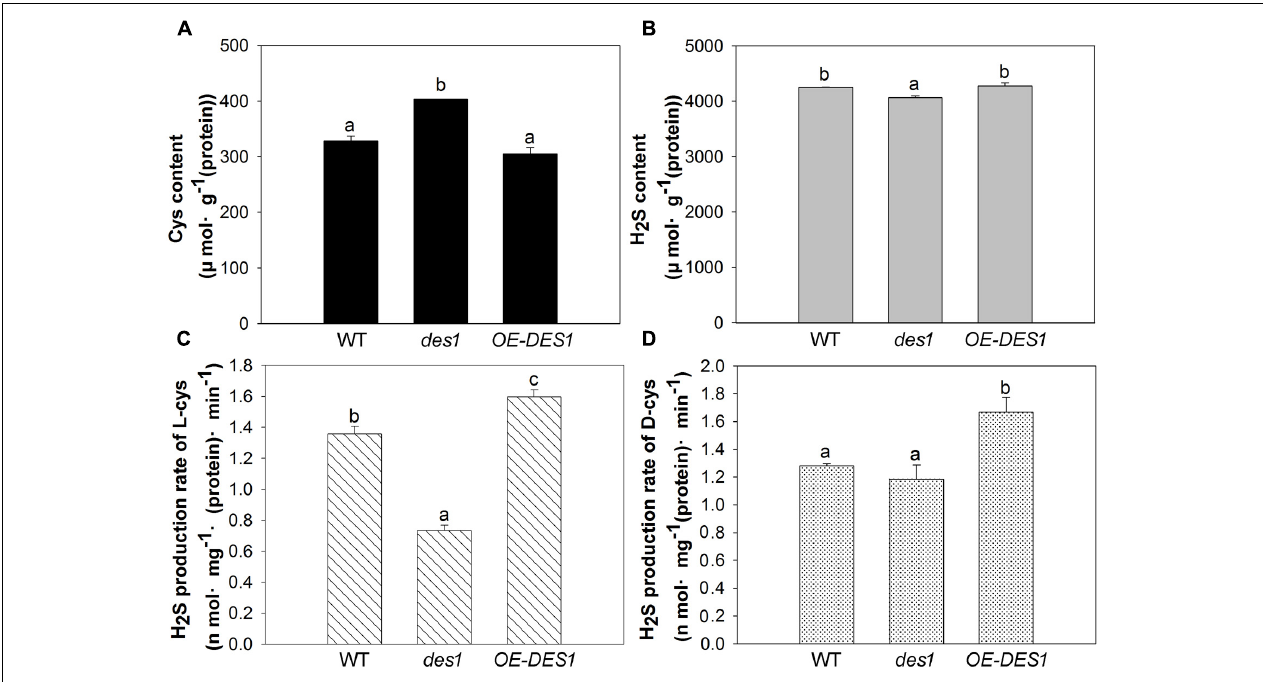
FIGURE 5 | Effects of drought stress on the H 2 S-related physiological indices in the mitochondria of WT, des1 and OE-DES1 . Leaves of 4-week-old after withholding water for 1 week were collected and the mitochondria were isolated and purified. (A) Cys contents of mitochondria were quantitated by the method described previously (Fu et al., 2012). (B) H 2 S contents of mitochondria were measured with electrodes (TBR4100 WPI, Sarasota, FL, United States). (C) H 2 S production rates of L -Cys and (D) H 2 S production rates of D -Cys in mitochondria of WT, des1 and OE-DES1 were measured with methylene blue method (Fu et al., 2012). Data are means ± SEs of three independent experiments; bars marked with the same letter did not differ significantly at p <